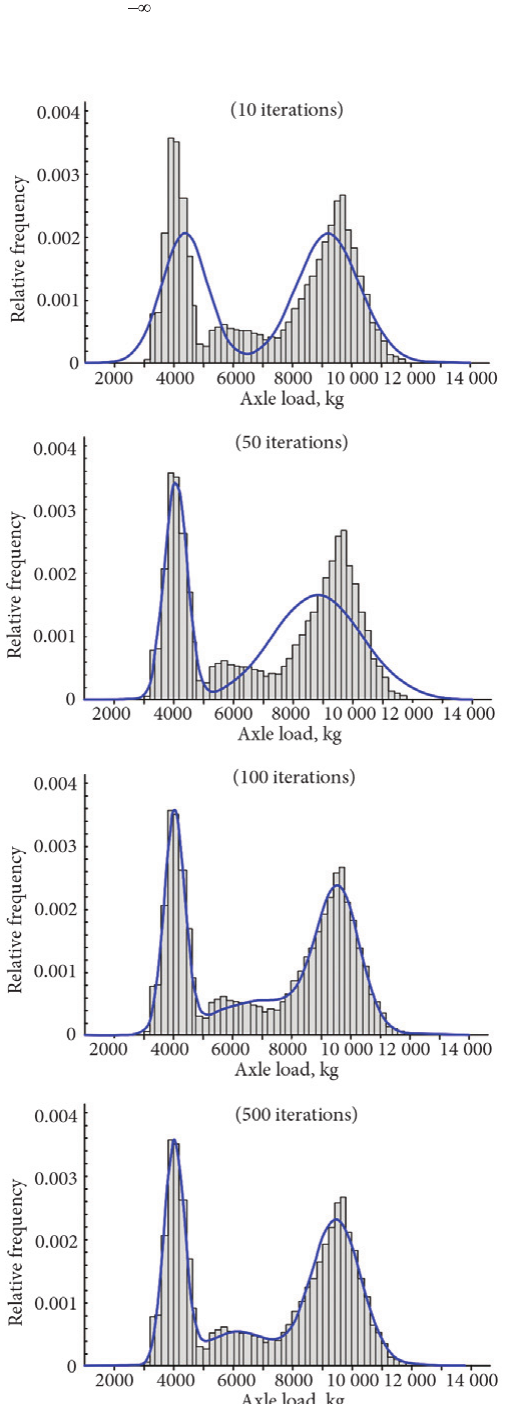
Fig. 2. Goodness of fit after various iterations